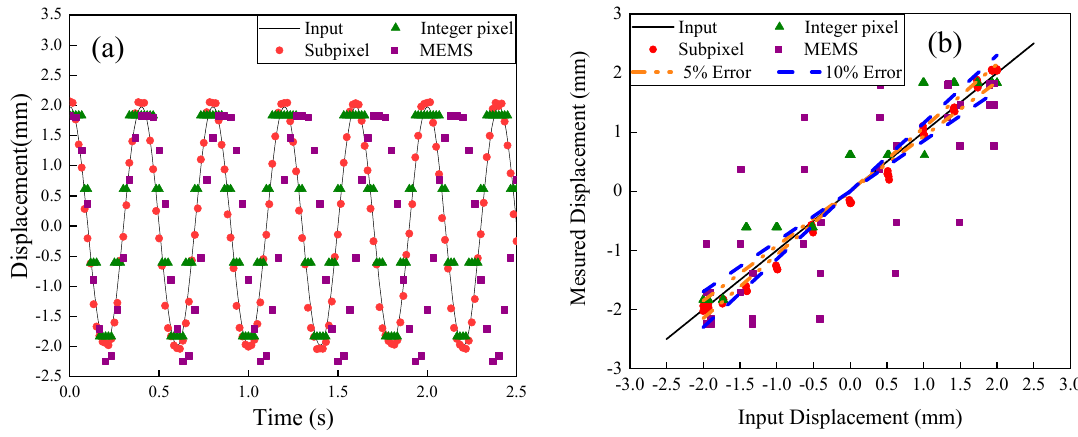
Figure 7. ( a ) Comparison of captured displacement with the input vibration at a frequency of 2.5 Hz and amplitude of 2 mm, and ( b ) Error analysis.